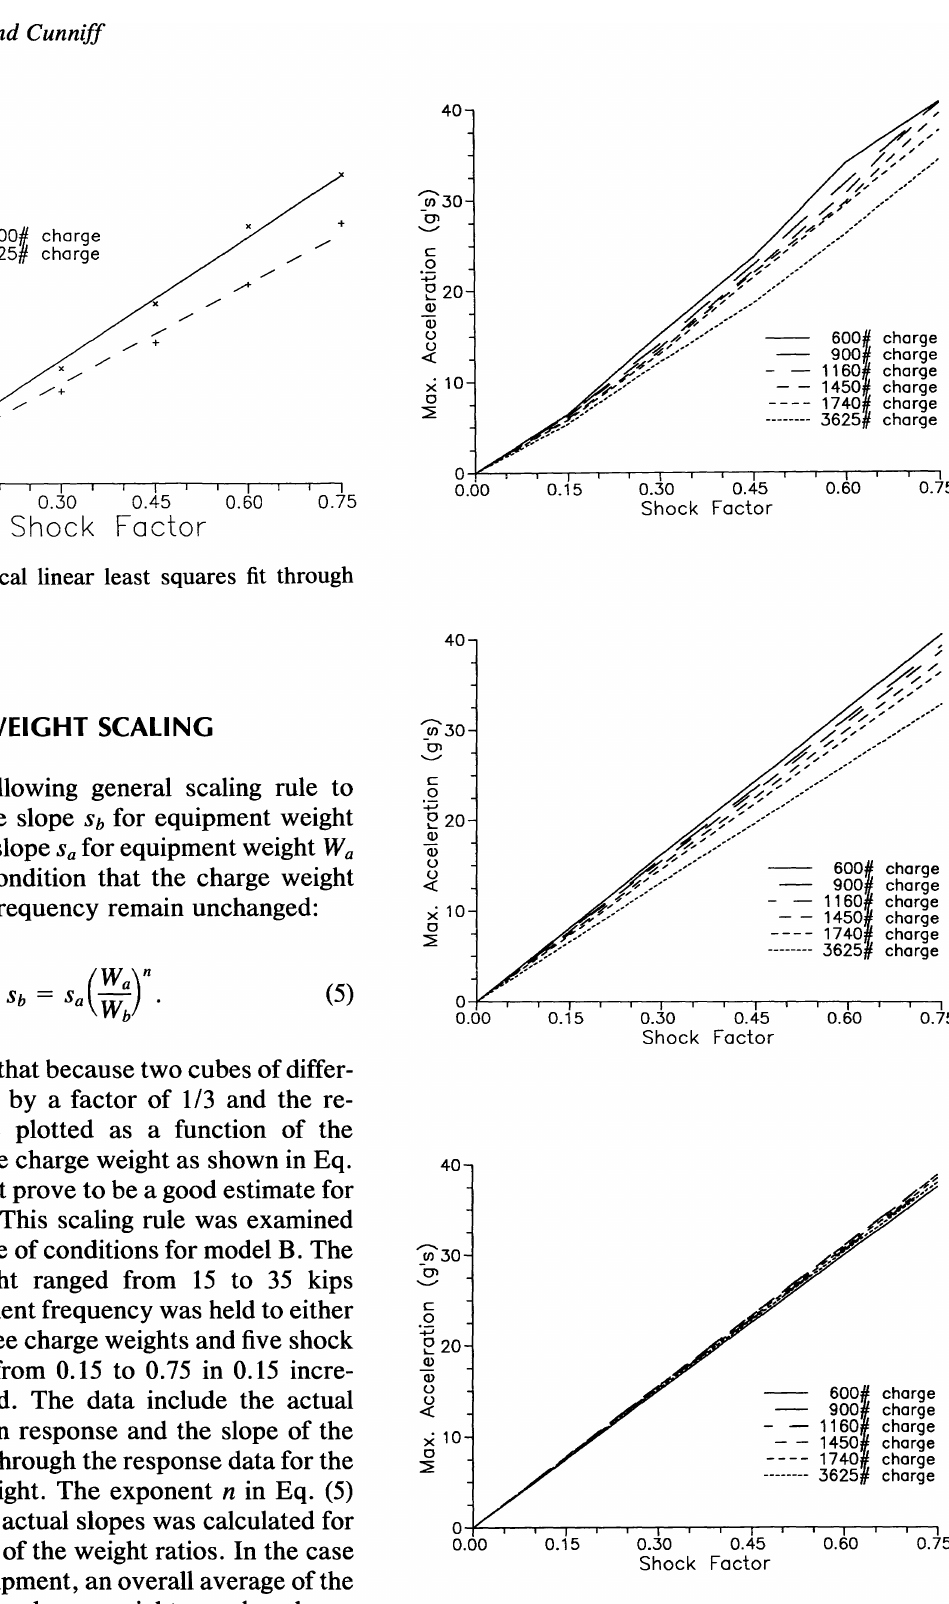
FIGURE 5 (a) Response data for fixed equipment weight and frequency, varying charge weights; (b) lin ear least squares fit for each charge weight; (c) slopes scaled to the 1160-lb. charge weight by Eq.